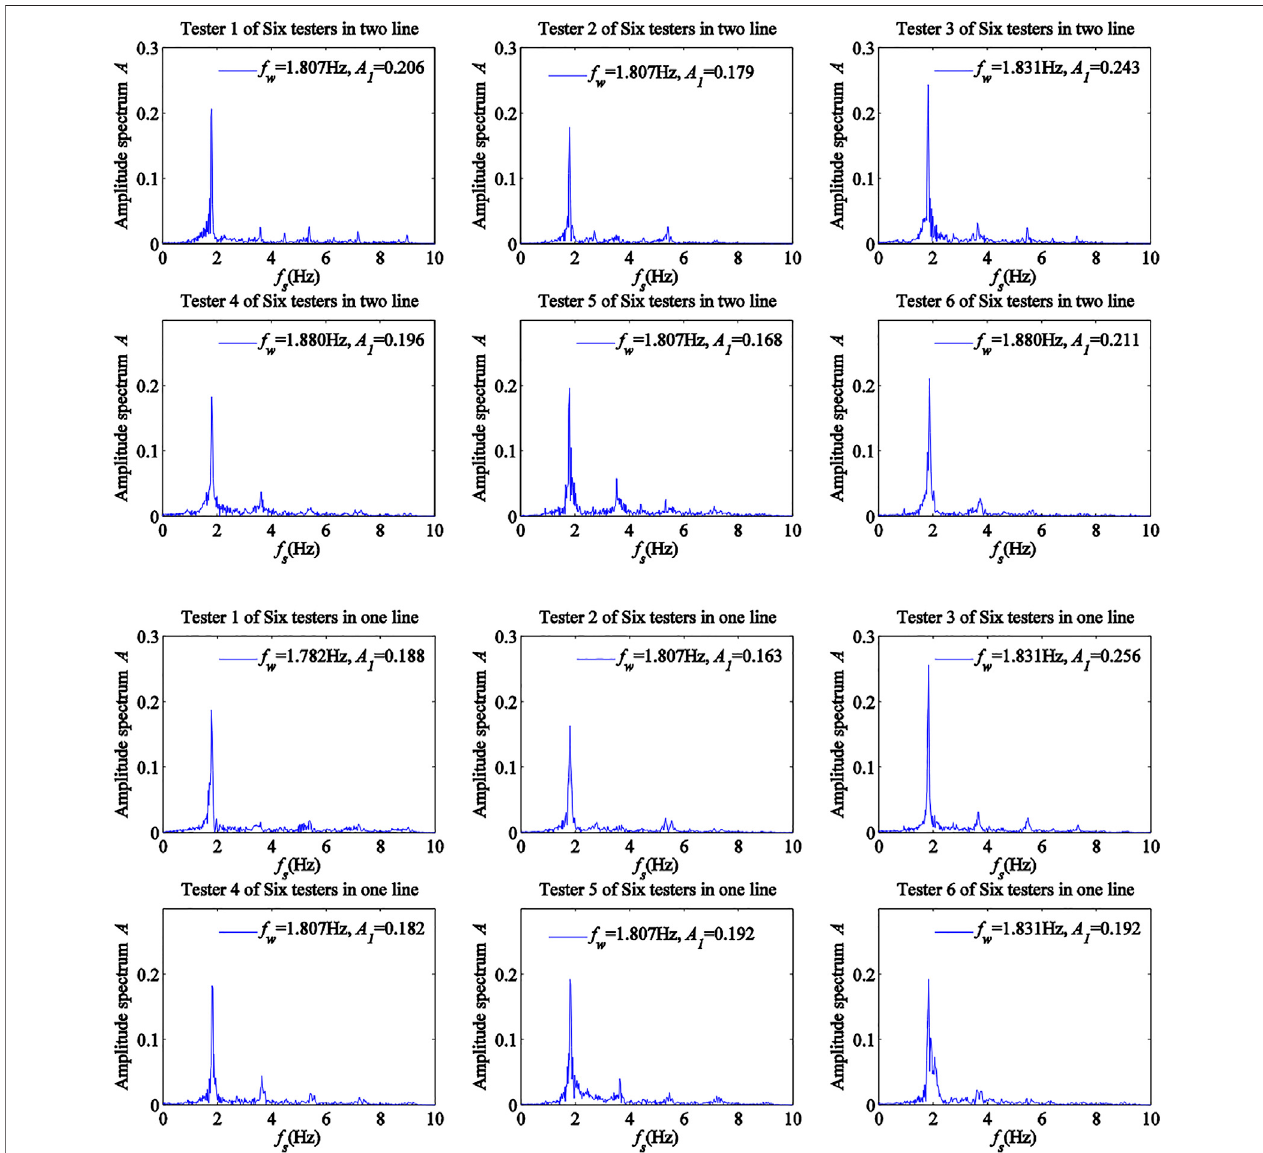
FIGURE 13 | Power spectra of pedestrian walking loads for six